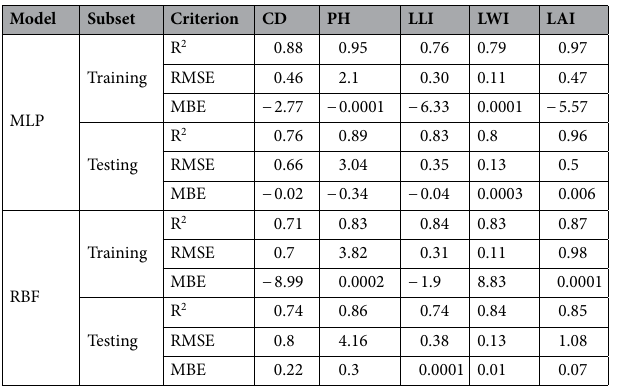
Table 1. Comparison statistics of multilayer perceptron (MLP) and radial basis function (RBF) for various morphological traits of pomegranate. PH plant height, CD crown diameter, LLI leaf length index, LWI leaf width index, LAI leaf area index, R 2 coefficient of determination, RMSE root mean square error, MBE mean bias